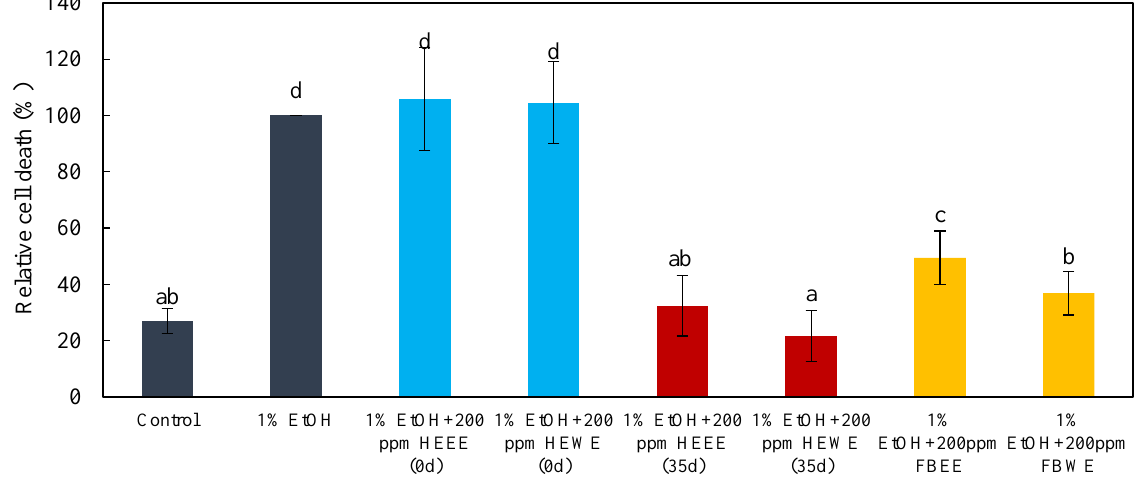
Figure 7. Effect of post-treatment with the hot water and ethanol extract of Hericium erinaceus solid-state fermented wheat product, fruiting body, and wheat on the brain cells of zebrafish embryos. The bar graphs represent the mean number of acridine orange-labeled cells, mean ± S.D.; n = 6 embryos. a–d The mean cell death values with different letters are significantly different ( p < 0.05).